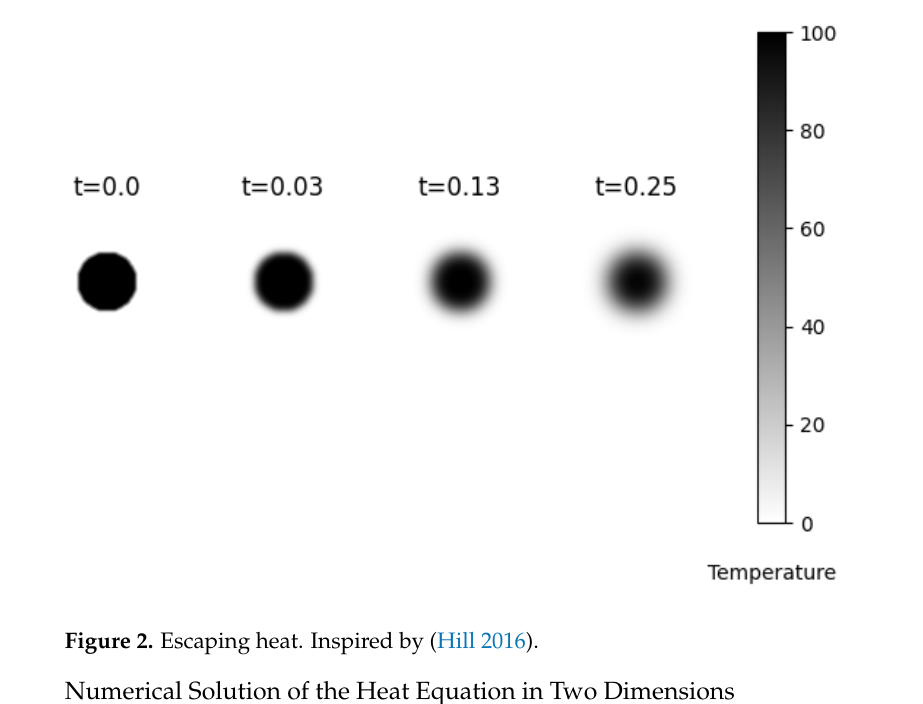
Figure 2. Escaping heat. Inspired by (Hill 2016).